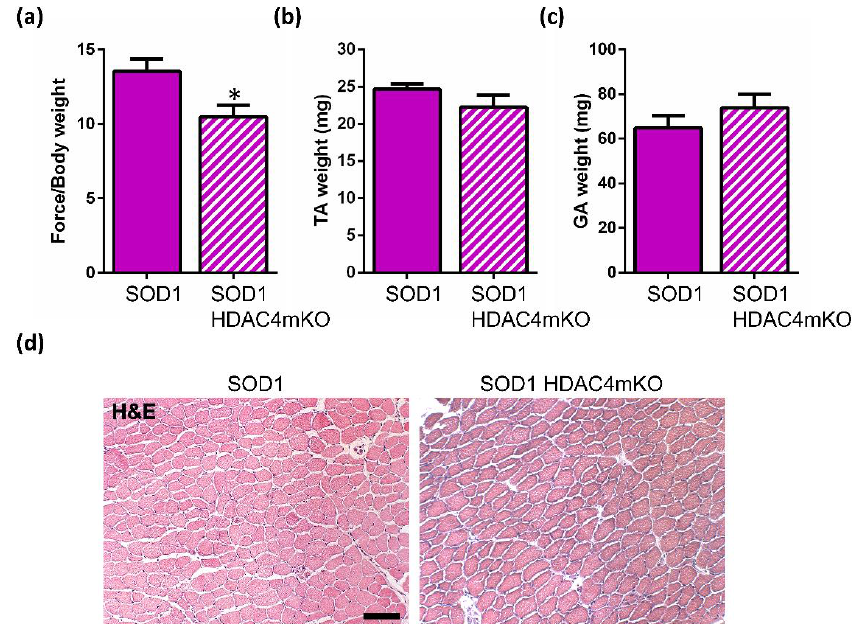
Figure 3. Deletion of HDAC4 negatively affects muscle performance in female SOD1 mice at a pre-symptomatic stage of the disease. ( a ) Muscle performance of SOD1 and SOD1 HDAC4mKO mice by grip test, at 12 weeks of age. Data are expressed as the mean of developed force over the mouse weight, +/ − SEM. N = 3 mice for genotype; * p < 0.05 by Student’s t -test. ( b ) Tibialis Anterior (TA) muscle weight of SOD1 and SOD1 HDAC4mKO mice at 12 weeks of age. Data are expressed as mean +/ − SEM. n = 5 SOD1 and n = 7 SOD1 HDAC4mKO mice. ( c ) Gastrocnemius (GA) muscle weight of SOD1 and SOD1 HDAC4mKO mice at 12 weeks of age. Data are expressed as mean +/− SEM. n = 8 SOD1 and n = 10 SOD1 HDAC4mKO mice. ( d ) Representative images of TA muscle histology of female SOD1 and SOD1 HDAC4mKO littermates, at 12 weeks of age. Scale bar = 100 μ m.